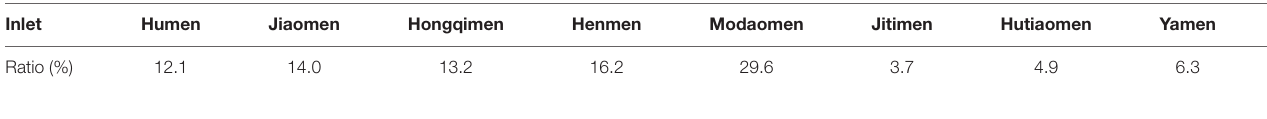
TABLE 1 | Freshwater discharge ratio for each inlet. Inlet Humen Jiaomen Hongqimen Henmen